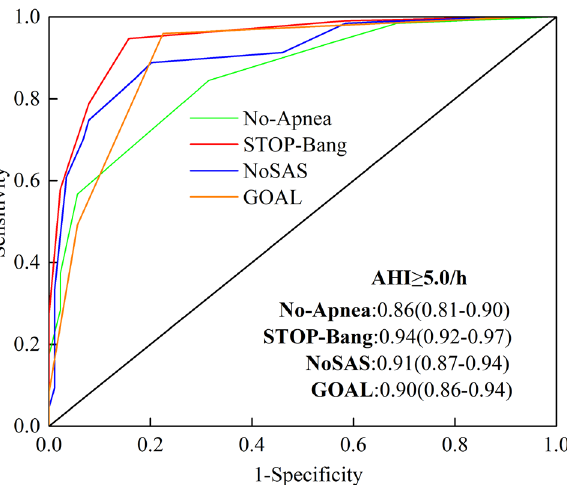
Figure 2. ROC curves of four screening tools (No-Apnea score, STOP-Bang questionnaire, NoSAS score and GOAL questionnaire) with an AHI cut-off ≥ 5 events/h. The area under the ROC curve (AUC) closer to 1 indicates the higher diagnostic accuracy of the screening questionnaire. AUC data are presented as values (95% confidence intervals). ROC receiver-operating curve, AHI apnea hypopnea index, AUC area under the